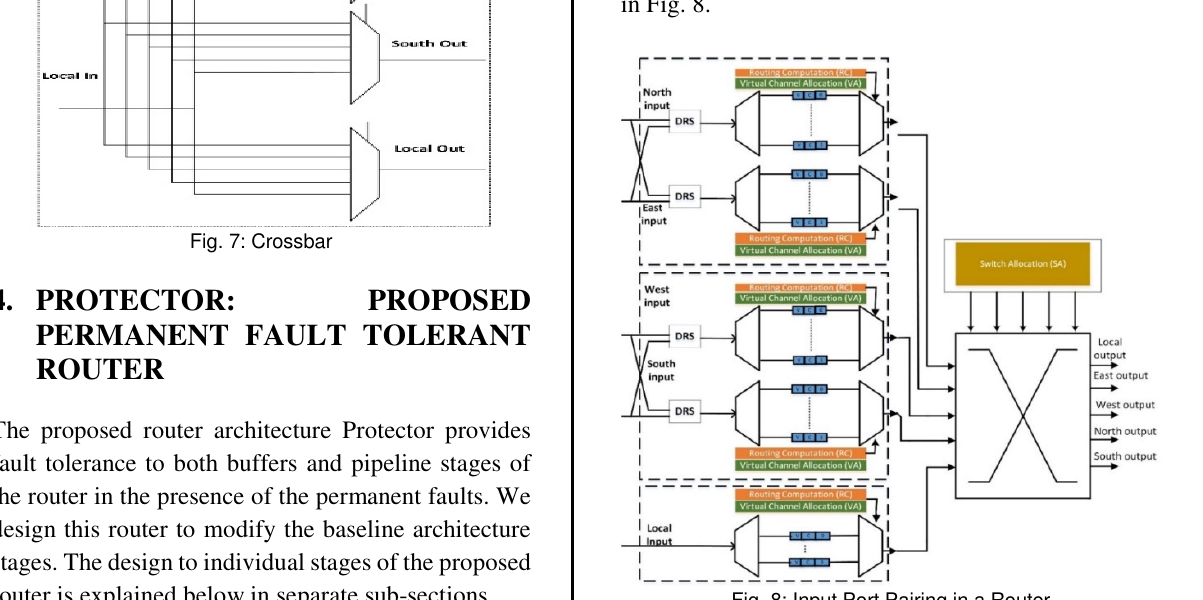
Fig. 8: Input Port Pairing in a